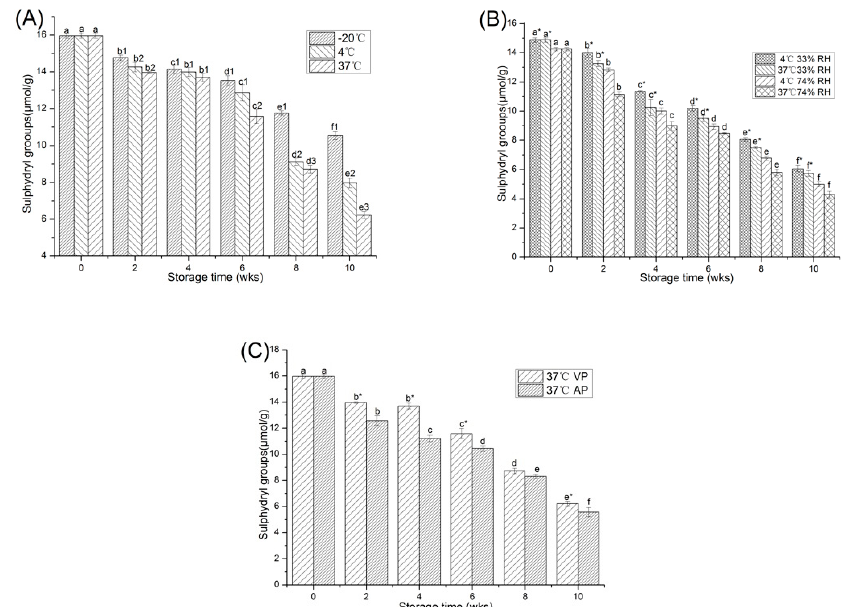
Figure 1. Changes in the free sulfhydryl content of PPI stored at different temperature ( A ), relative humidity ( B ) and packaging methods ( C ). a–f means the significant difference between the same treatments with different weeks ( p < 0.05). 1–3 means the significant difference between the same weeks with different temperature ( A ) (p < 0.05 ) . * means the significant difference between the same weeks and temperature with different relative humidity ( B ) or between the same weeks with different packaging methods ( C ) (p < 0.05 ) .